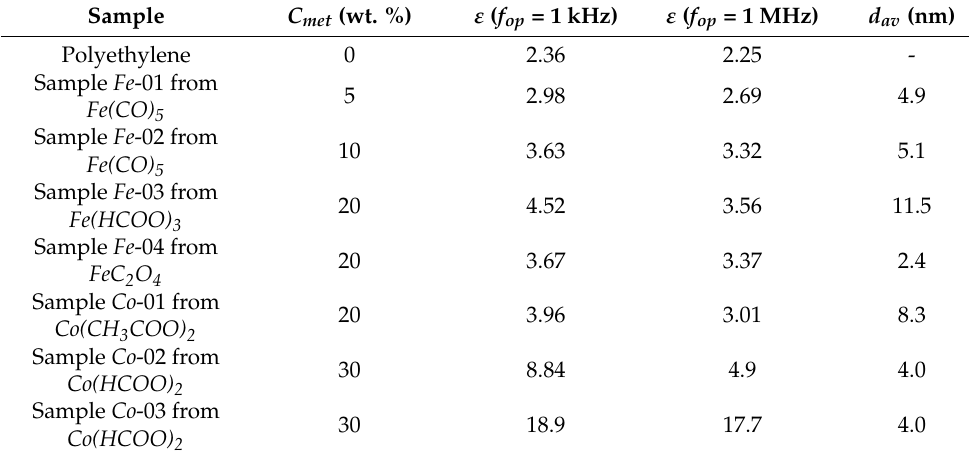
Table 3. Measurement results for composite nanomaterials.